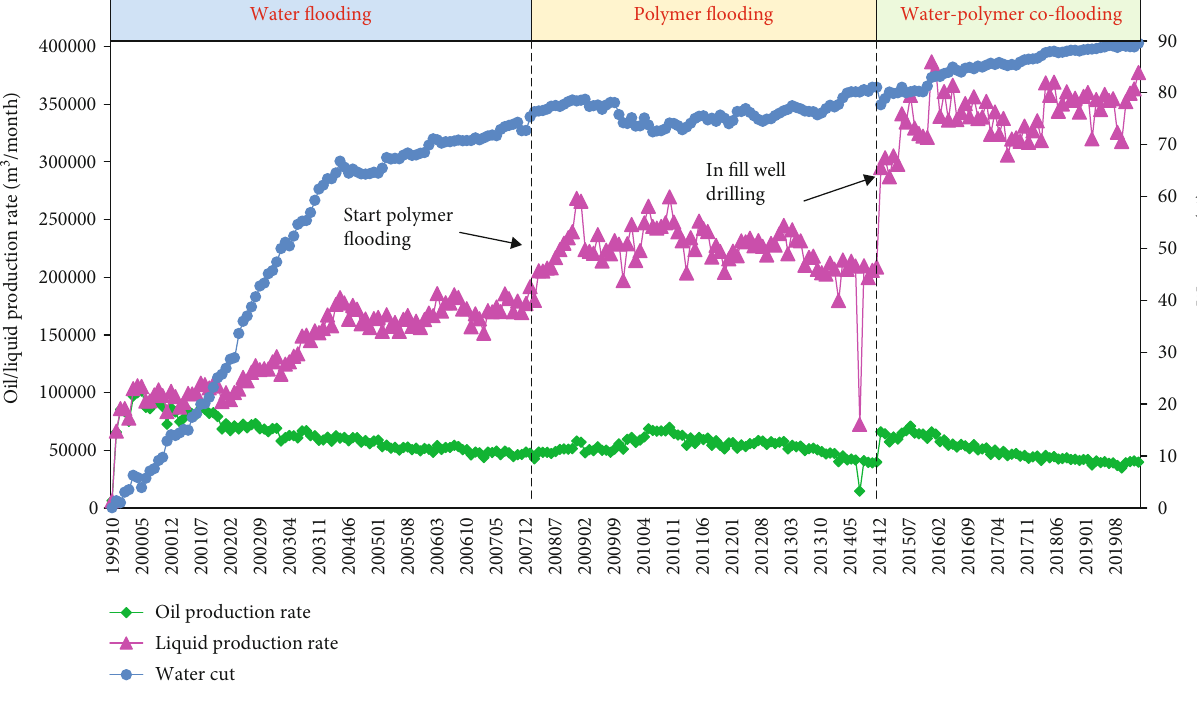
Figure 16: Production history of JZ oil fi